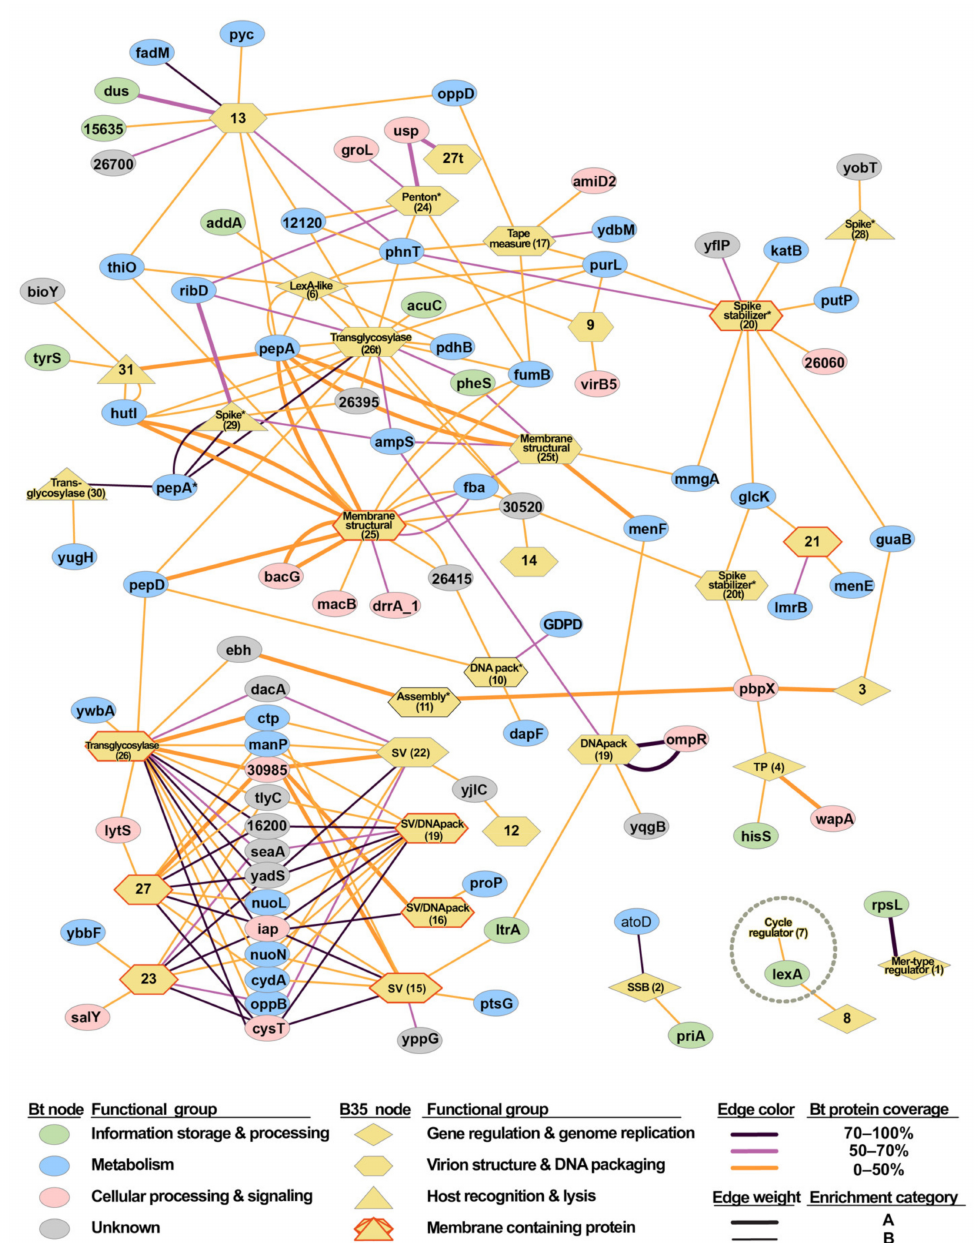
Figure 5. Bam35– B. thuringiensis protein interaction network based on the Y2H–Illumina screening. Network of the 182 detected interactions (195 bait–prey pair combinations) between the host proteins and the viral proteins (Supplementary Table S6). Host proteins (Bt nodes) are represented by ellipses colored according to their functional groups and the viral proteins are represented by yellow nodes shaped according to their functional groups. Viral nodes are labeled by their known or suggested (*) function and their gene number (between brackets) is indicated in Supplementary Figure S1. SV stands for special vertex localization. Host proteins are identified by their annotated function or, for the unknown function proteins, their locus number in the HER1410 genome (accession numbers available in Supplementary Table S6). Each interaction (bait–prey combination) is represented as a line connecting two nodes. Line colors indicate the coverage of the host protein by the detected prey fragment, where the line weight indicates the enrichment category of the interaction (B for prey proteins detected as 0.25–10% of the sample counts and A for 10–100%). The interaction between the viral P7 and the host LexA that was detected in this work and previously published in Caveney et al. [28] is indicated with a gray circle. PepA* refers to the M42 family metallopeptidase that is encoded by the host gene HBA75_23575 and PepA refers to the cytosol aminopeptidase that is encoded by the host gene